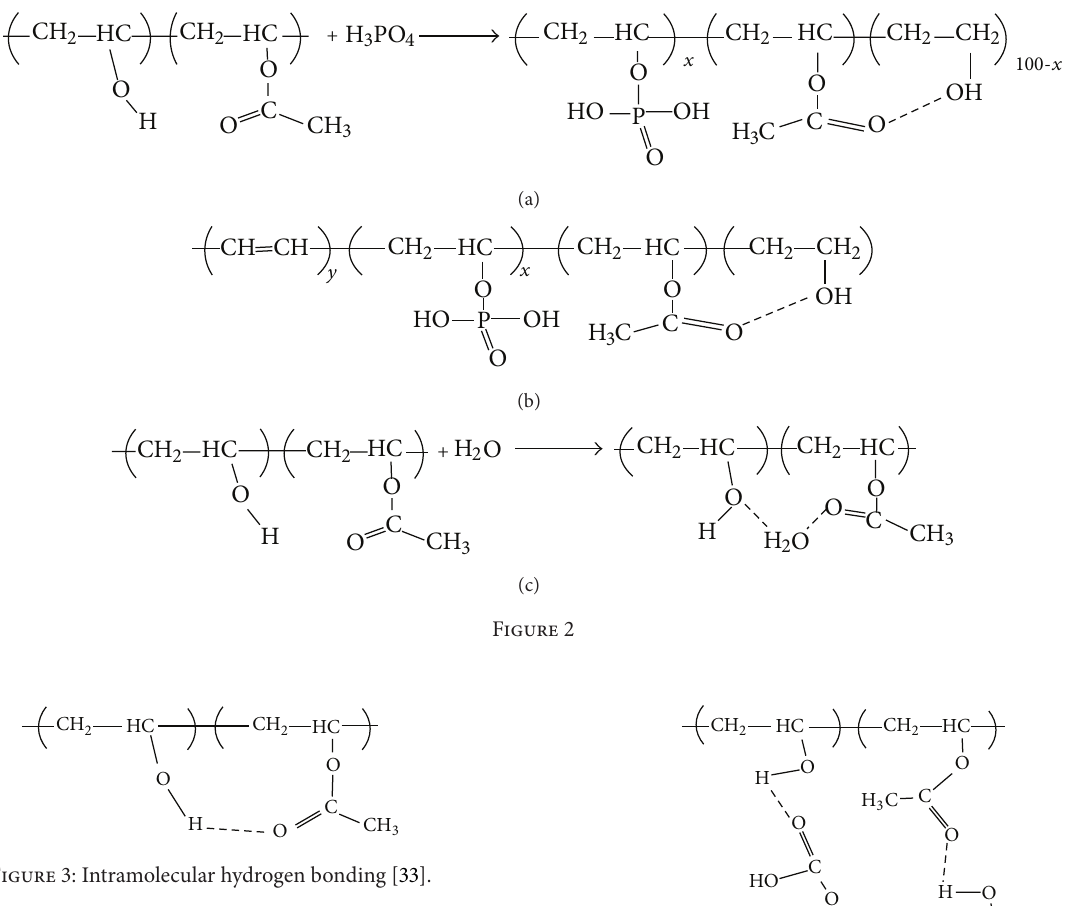
Figure 4: Intermolecular hydrogen bonding